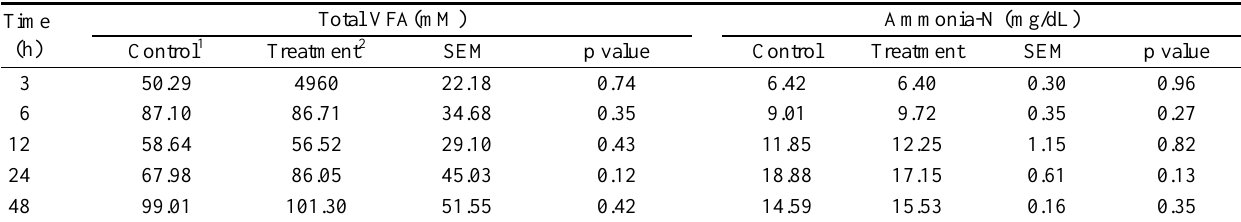
Table 3. Effects of supplementation of RPAAs and RPF on ruminal total VFA and ammonia-N concentrations, in